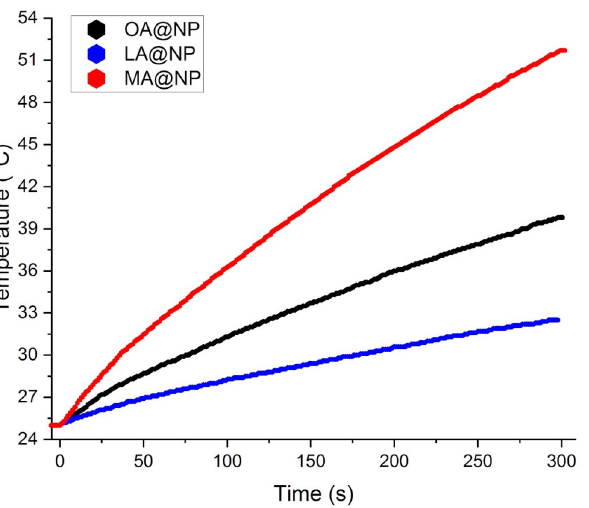
Figure 5. Temperature kinetics of water suspension of OA@NP (conc. 12.0 mg/mL), LA@NP (13.6 mg/mL), and MA@NP (27.5 mg/mL) exposed to an alternating field (17 kA/m amplitude and 183 kHz frequency).